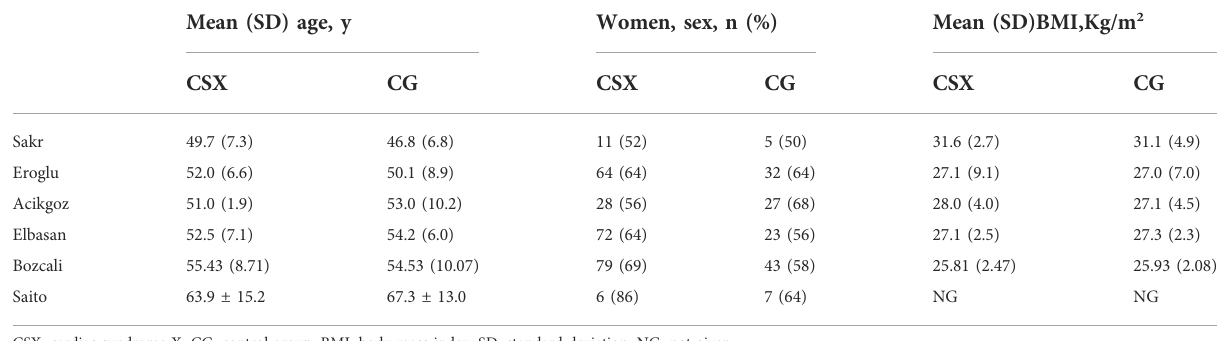
TABLE 2 Participant characteristics.